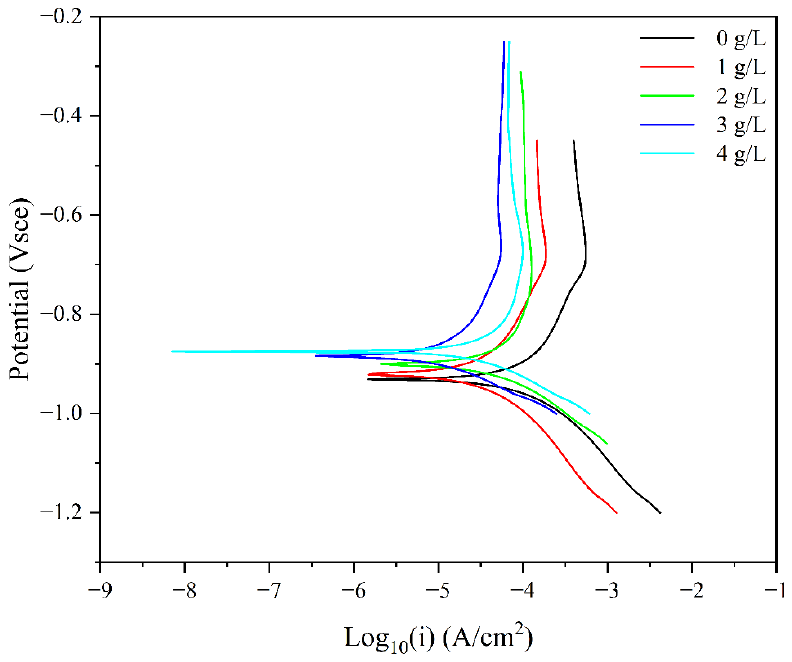
Figure 3. Potentiodynamic polarization curves of carbon steel electrodes in different concentrations of corrosion inhibitor solutions.